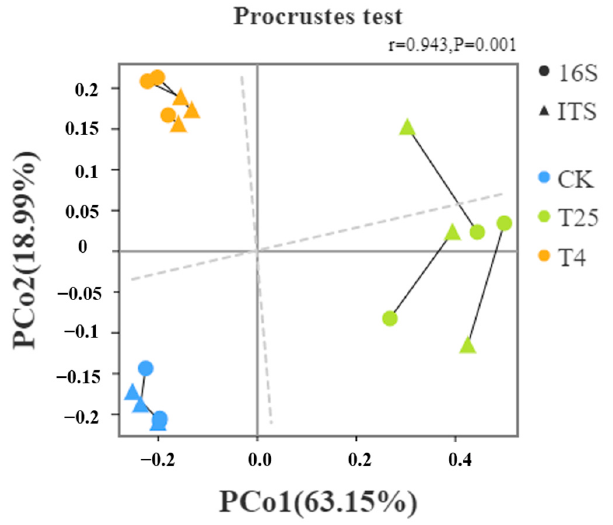
Figure 1. Scatter plot of 16S and ITS β -diversity index correlation ratio.